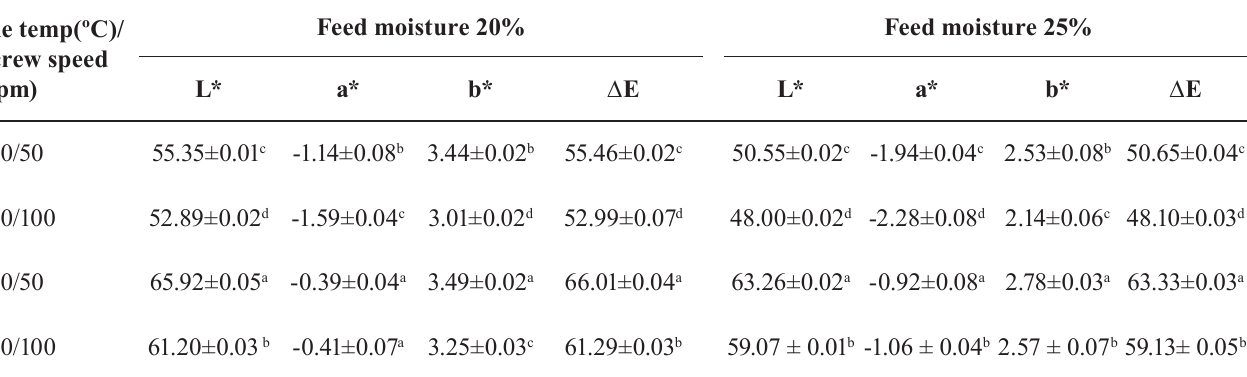
TABLE IV - Effect of extrusion cooking parameters (feed moisture, barrel temperature and screw speed) on colour properties